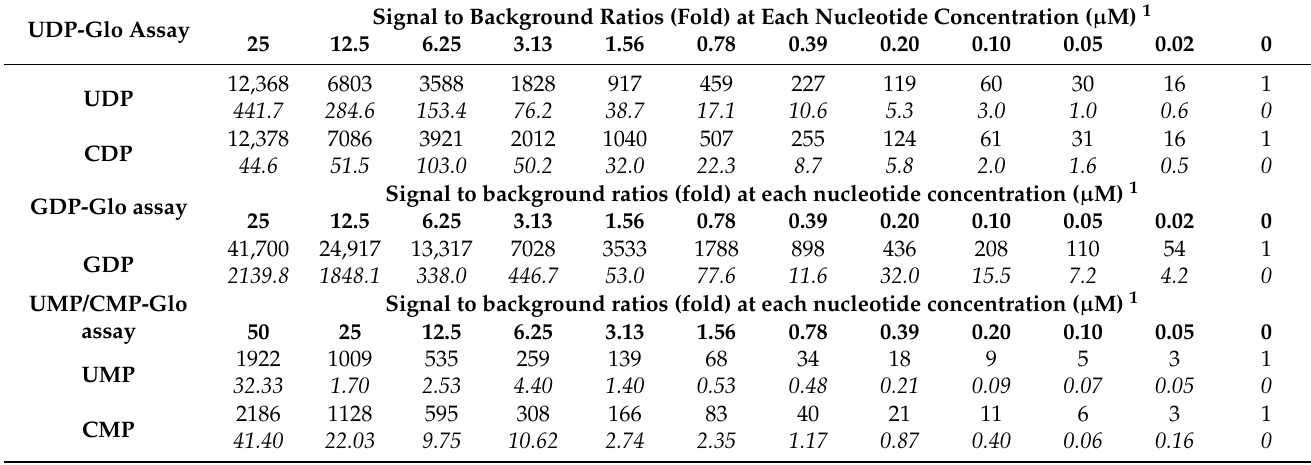
1 Signal to background ratios represents the mean of three replicates. The numbers below SBs represent the standard error values for each SB point derived from the